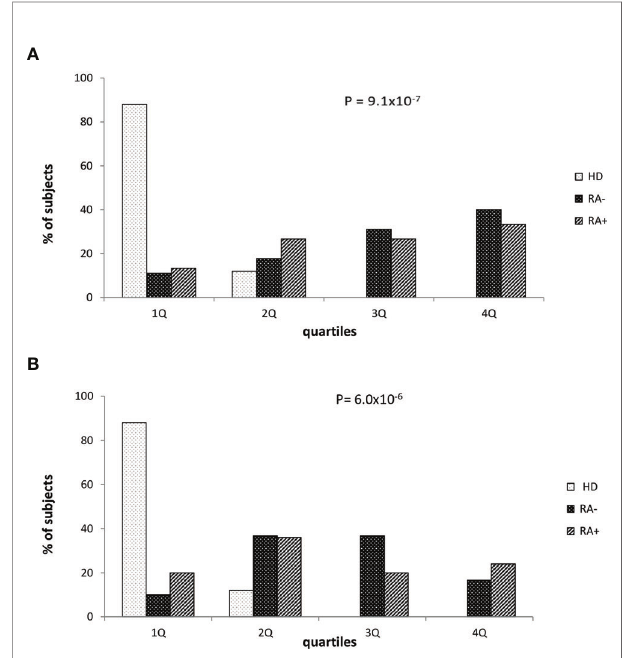
FIGURE 2 | Healthy donors and patients with seronegative or seropositive arthritis according to the quartile distribution of absorbance levels in patients who were not (A) or were treated with corticosteroid (B) . RA seronegative (RA-) patients, RA seropositive (RA+) patients and healthy donors (HD). Quartile distribution was determined on the basis of the following threshold values: Q1 < 0.045; 0.045 ≤ Q2 ≤ 0.112 or Q2 0.045-0.112; 0.113 ≤ Q3 ≤ 0.197 or Q3 0.113-0.197; Q4 ≥ 0.198. Statistical p value was obtained by c 2 for linear trend.